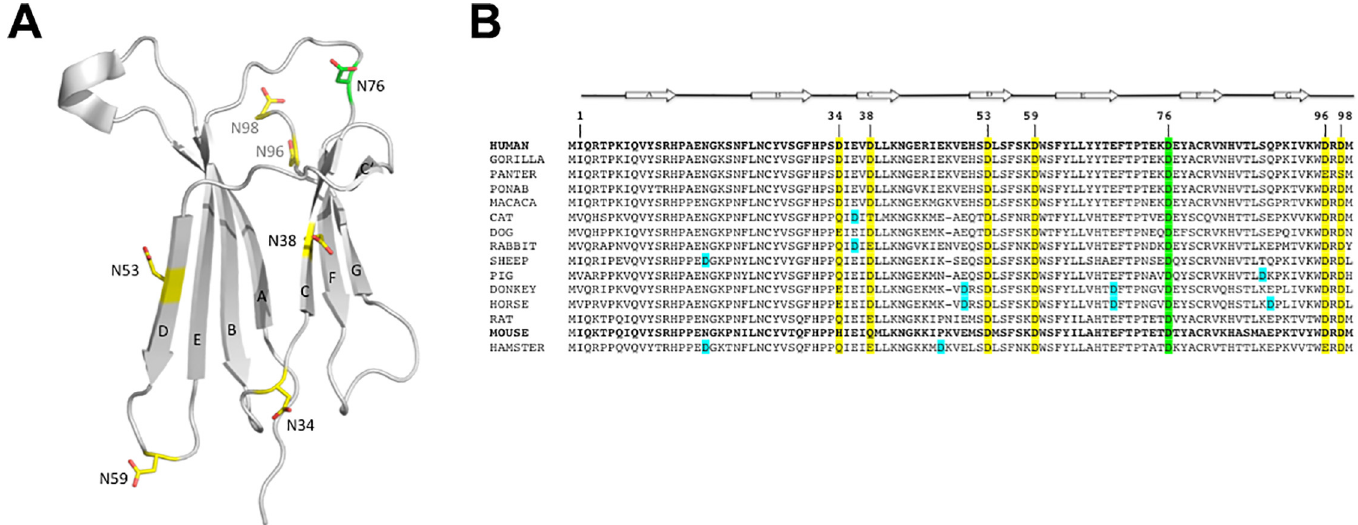
Fig 1. Distribution and conservation of Asp residues in β 2m. (A) Asp residues are mapped on a ribbon representation of wt β 2m structure (pdb code 2YXF), and shown as stick models. (B) Alignment of mammalian β 2m amino acid sequences, numbering according to the mature human protein; D76 is highlighted in green, while other conserved Asp residues are highlighted in yellow. Asp residues randomly located in different sequences are shown in